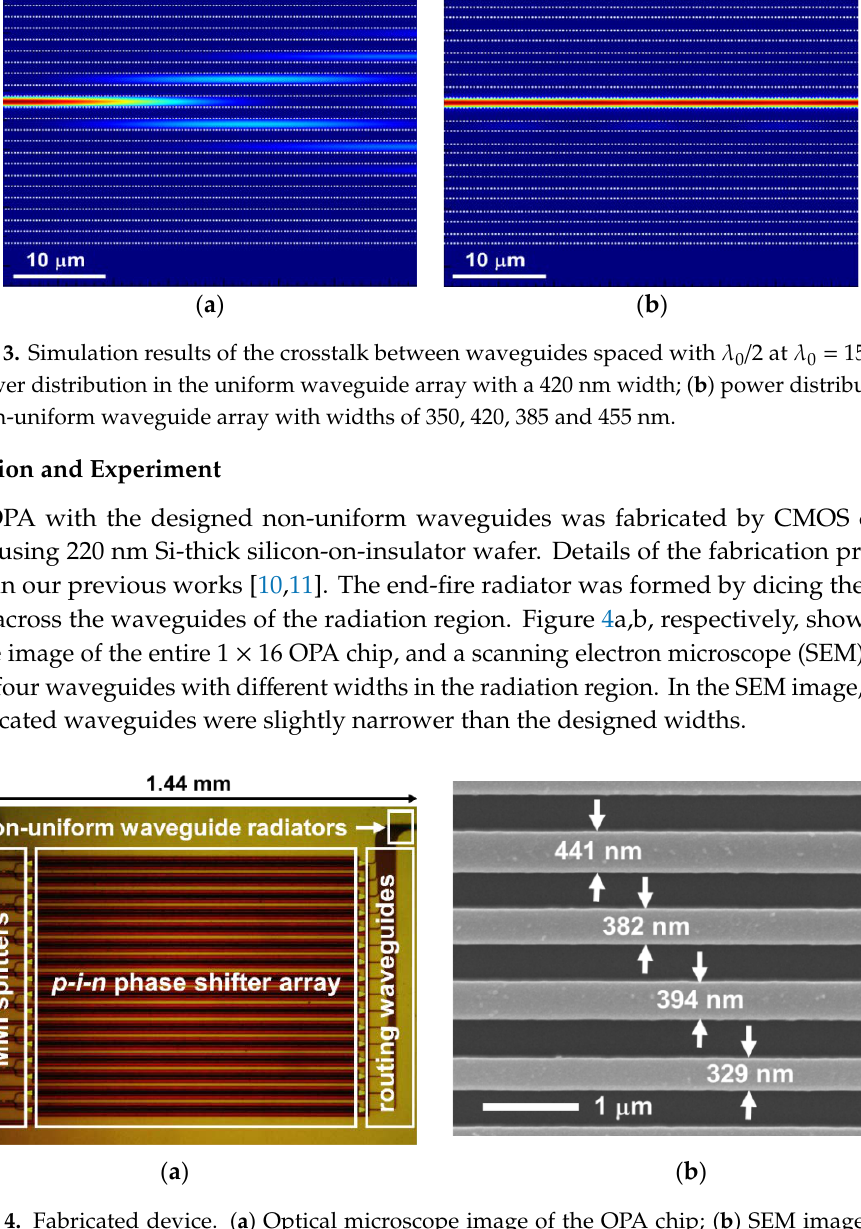
Figure 3. Simulation results of the crosstalk between waveguides spaced with λ 0 /2 at λ 0 = 1550 nm. ( a ) Power distribution in the uniform waveguide array with a 420 nm width; ( b ) power distribution in the non-uniform waveguide array with widths of 350, 420, 385 and 455 nm.